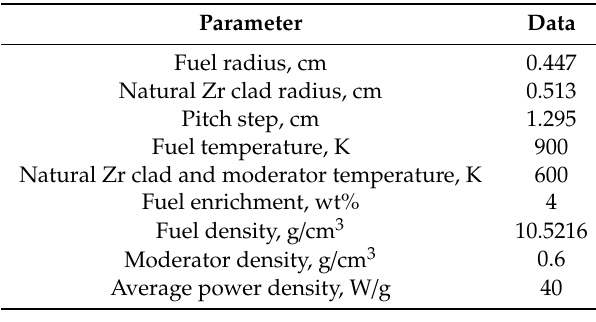
Table 1. BWR pin-cell parameters.